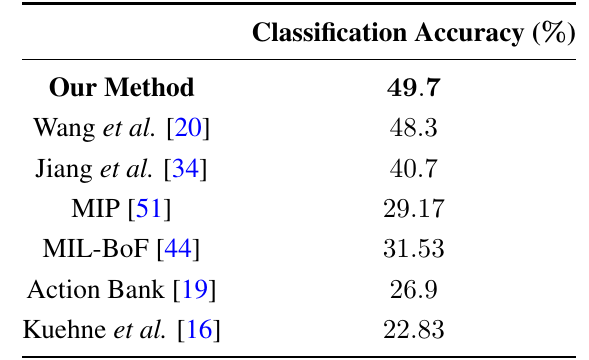
Table 3. Performance comparison of the proposed GPMK with previous methods in action classification literature (HMDB51